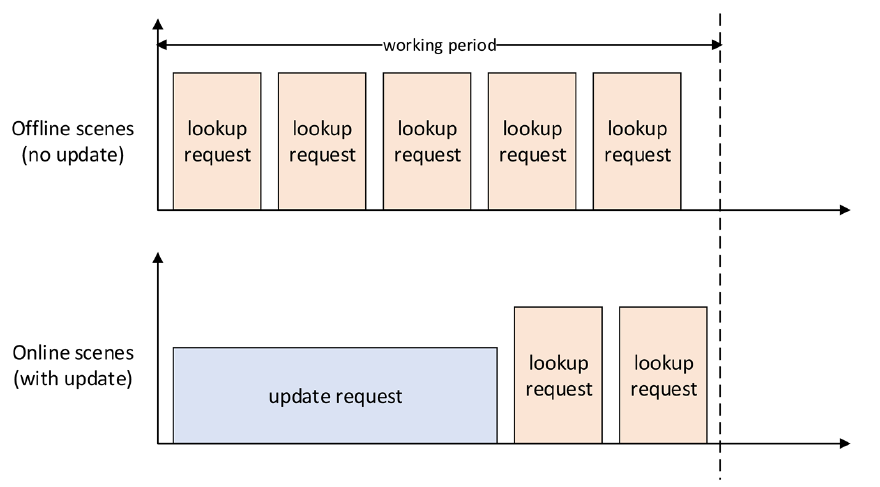
Figure 1. The two types of work